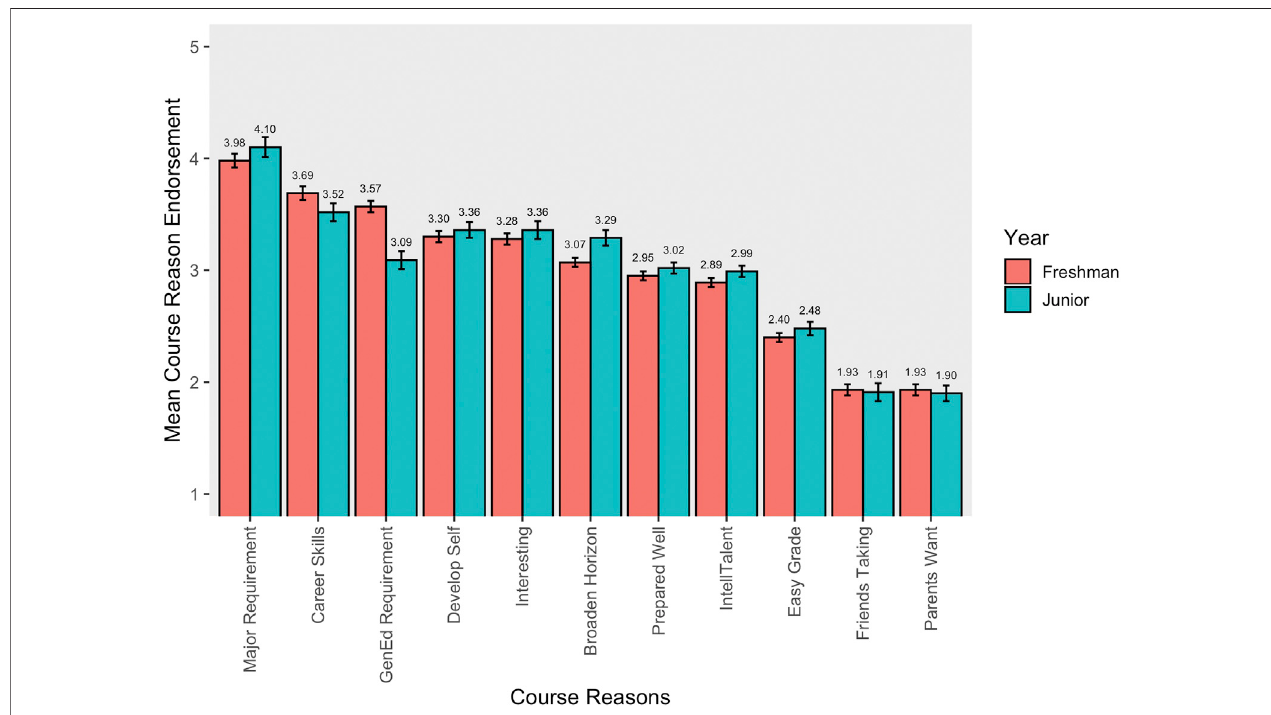
FIGURE 3 | Endorsement of course choice reasons for freshman and junior. Group comparison on endorsement of course choice reasons for freshman (left) and junior (right) . Mean and standard errors are presented; 1 (cid:1) the least important reason choice, 2 (cid:1) the second and third least important reason choices, 3 (cid:1) not the least nor most important reason choice, 4 (cid:1) the second and third most important reason choice, 5 (cid:1) the most important reason